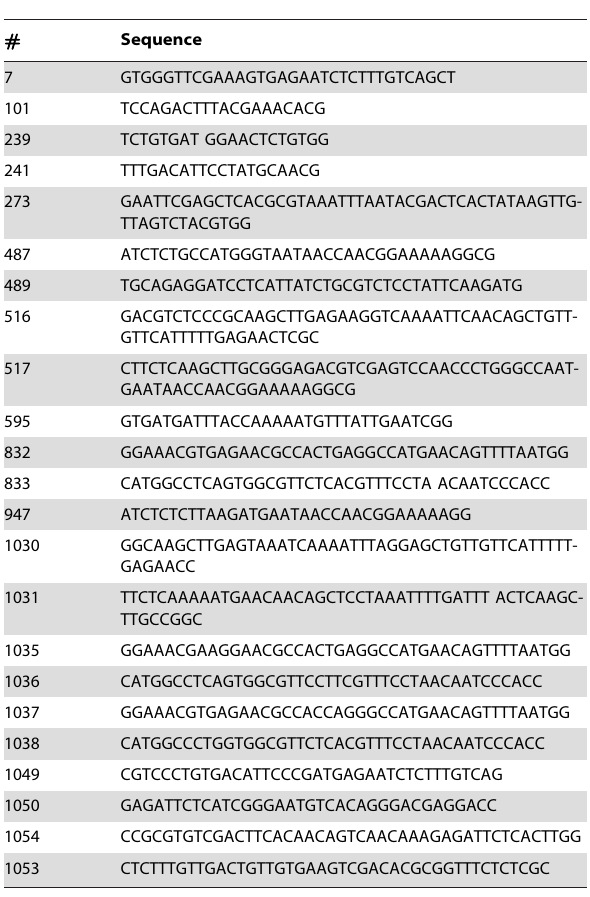
Table 1. Sequence of